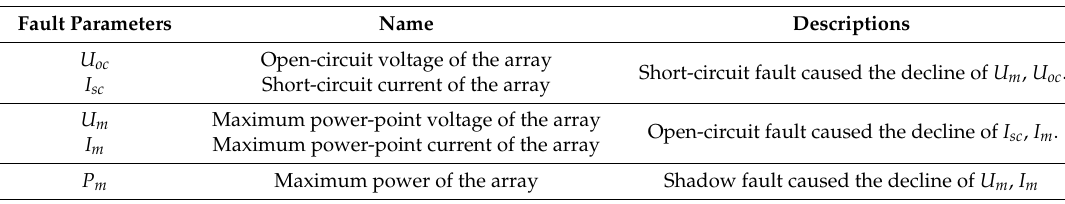
Table 2. Selected fault characteristic parameters.